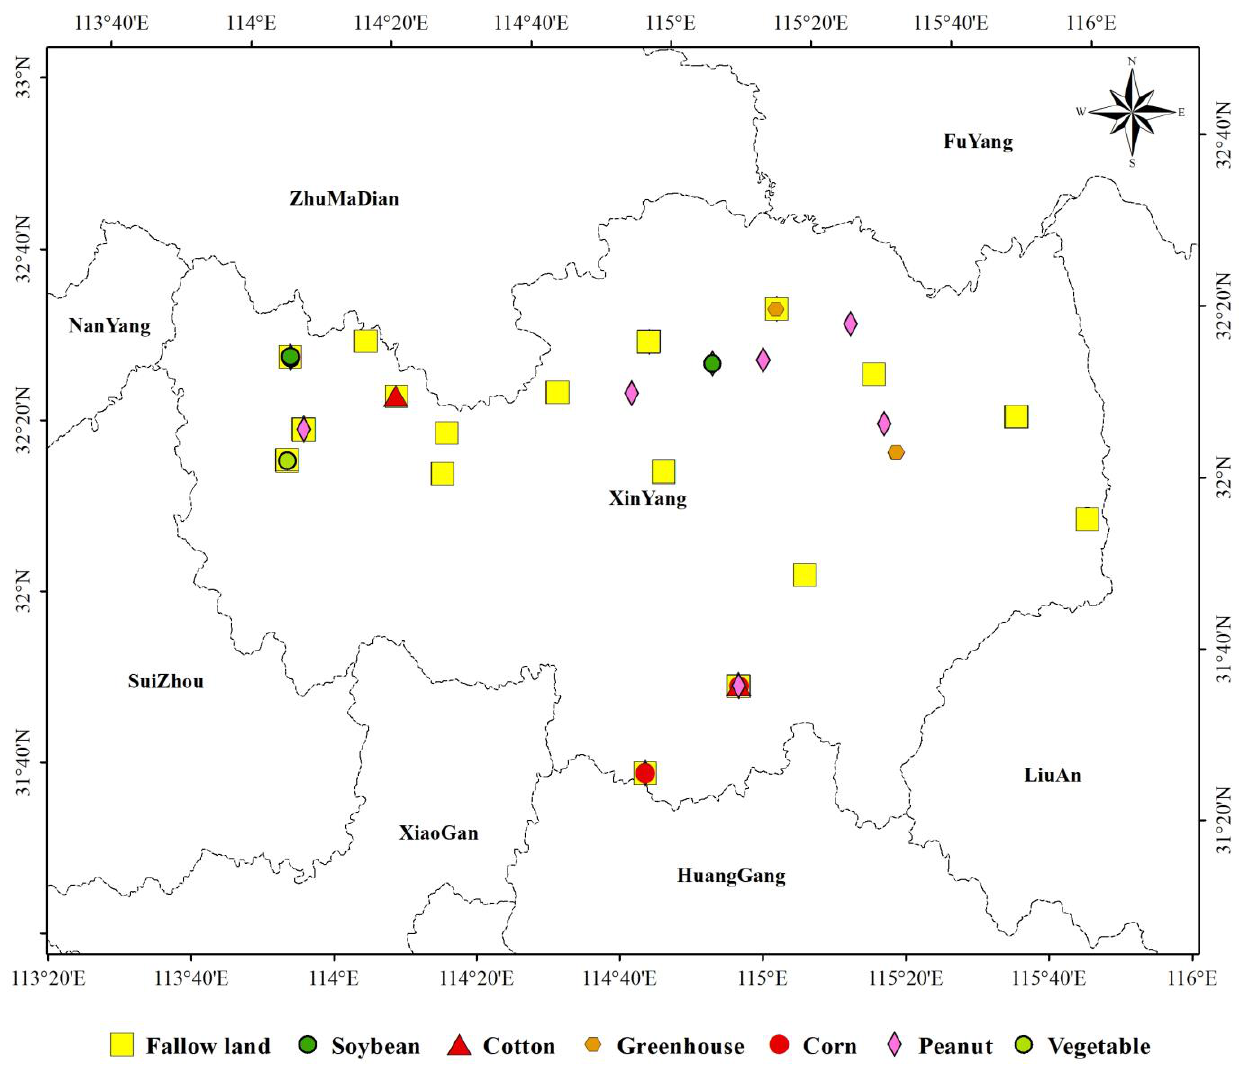
Figure 11. Spatial distribution map of cultivated land samples (Some samples are so close together that they cannot be distinguished on the map). Table 6. Descriptive statistics of the calculation results of EQI , EI , and S CEQI of 219 sample